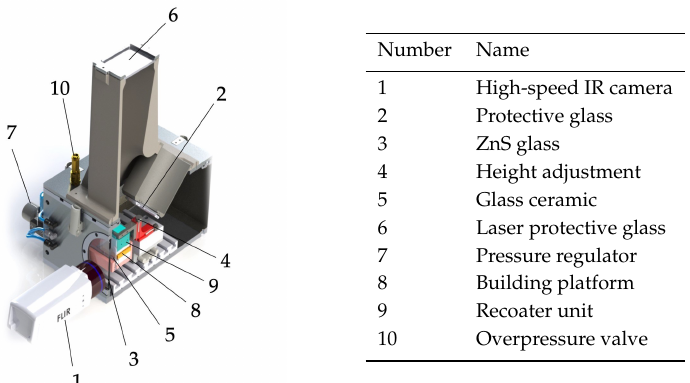
Figure 3. Sectional view of the PBF-LB/M chamber with a description of the various components Calibration of the thermographic imaging system With the chosen scanning speed of 0.375 m/s, the image details set on the camera,